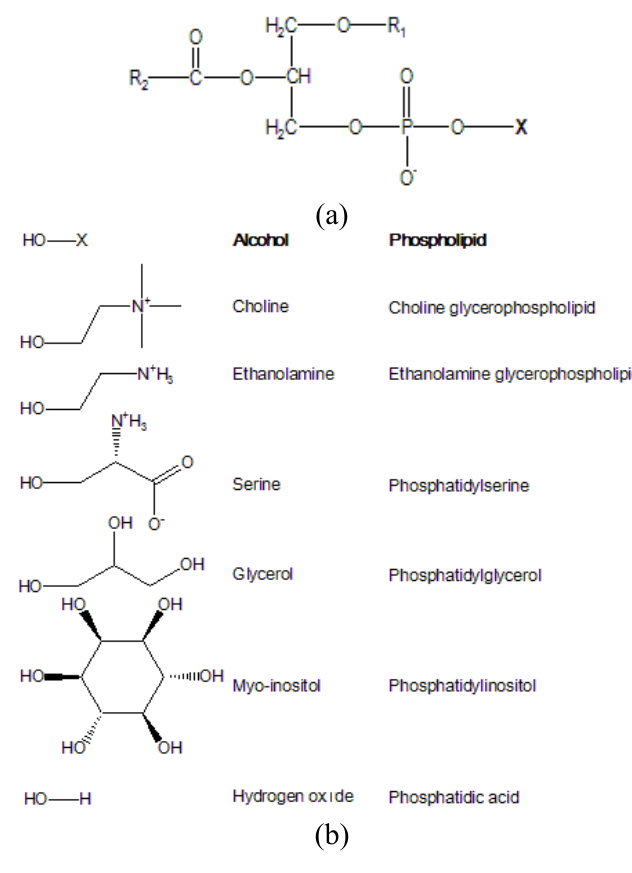
Figure 1. Basic phospholipid structure (a) and moieties of X